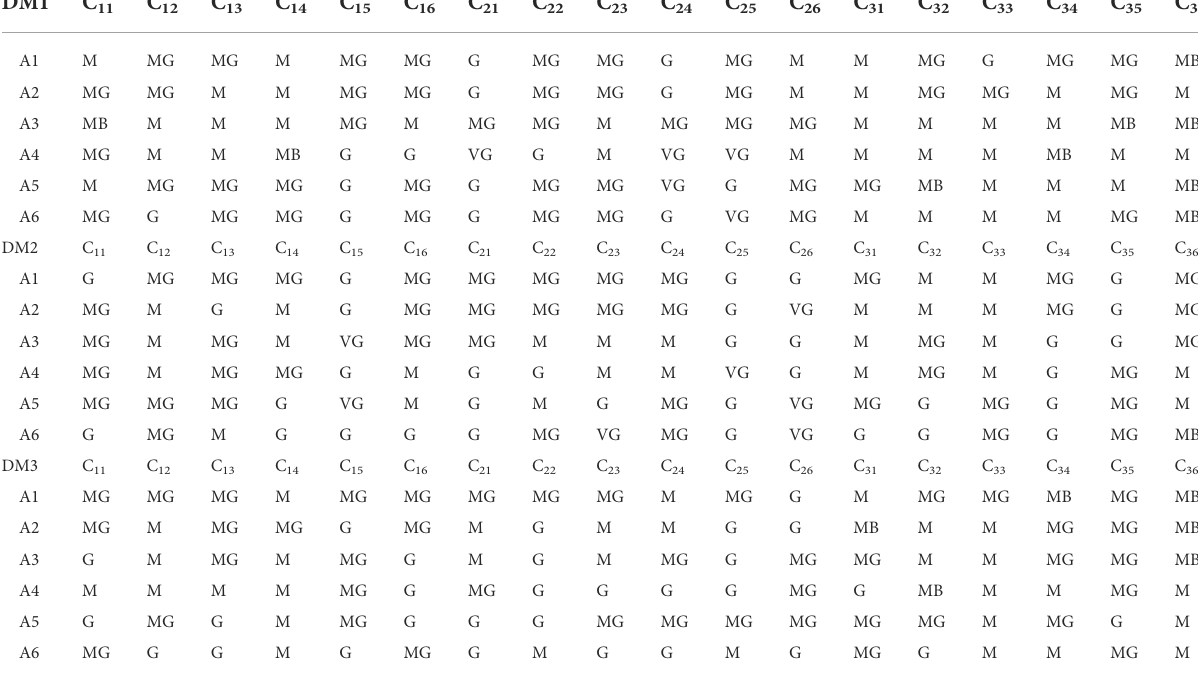
TABLE 7 Initial (starting) decision